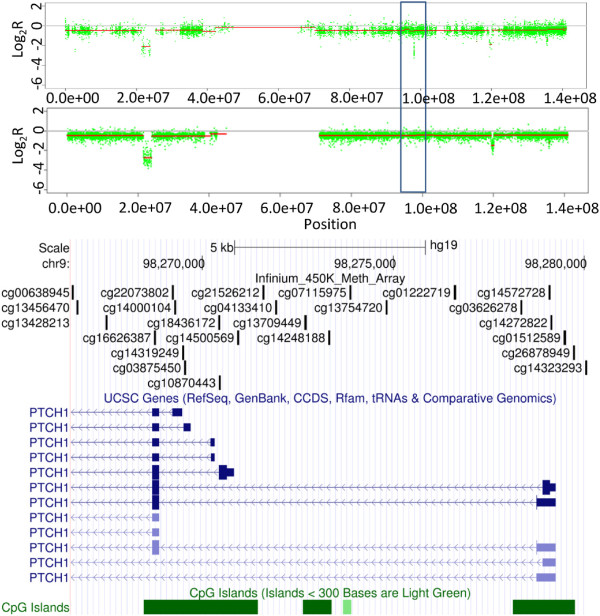
Infinium unique PTCH1 deletion. CN profiles for chromosome 9 for a single chondrosarcoma sample generated from Infinium HumanMethylation450 BeadChip (upper panel) and CytoSNP arrays (middle panel). The Infinium array-specific deletion of PTCH1 is highlighted (blue box).The lower panel shows the genomic organization of the Infinium unique PTCH1 region of deletion and the distribution of probes on the Infinium methylation, CytoSNP and SNP 6.0 arrays.